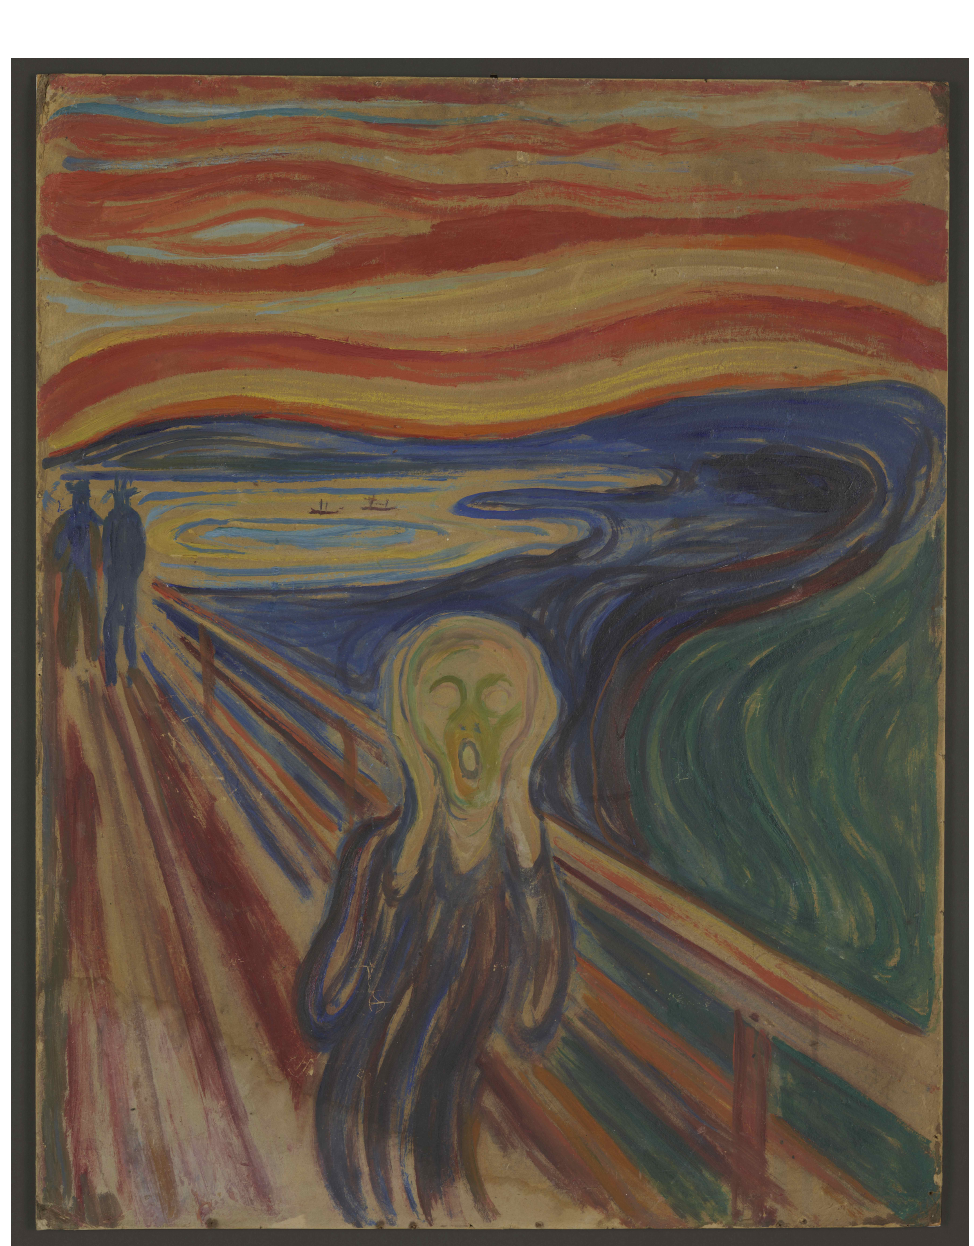
Figure 11: The Scream (1910?) ©